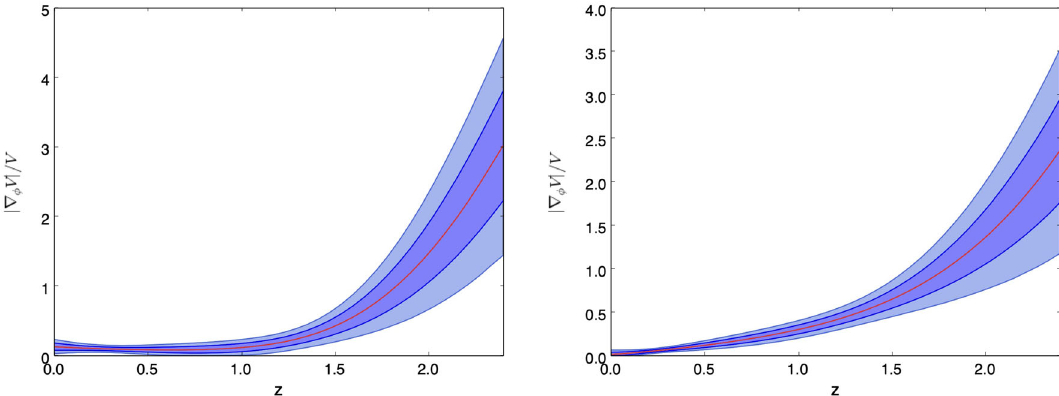
H 0 = 67 . 40 ± 0 . 5 km s − 1 Mpc − 1 has been merged to the expansion rate data used in the GP. The reconstruction obtained is for the f ( R ) model given by Eq. (18). The solid line corresponds to the mean of the reconstruction, and the shaded blue regions to the 68% and 95% C.L. of the reconstruction, respectively